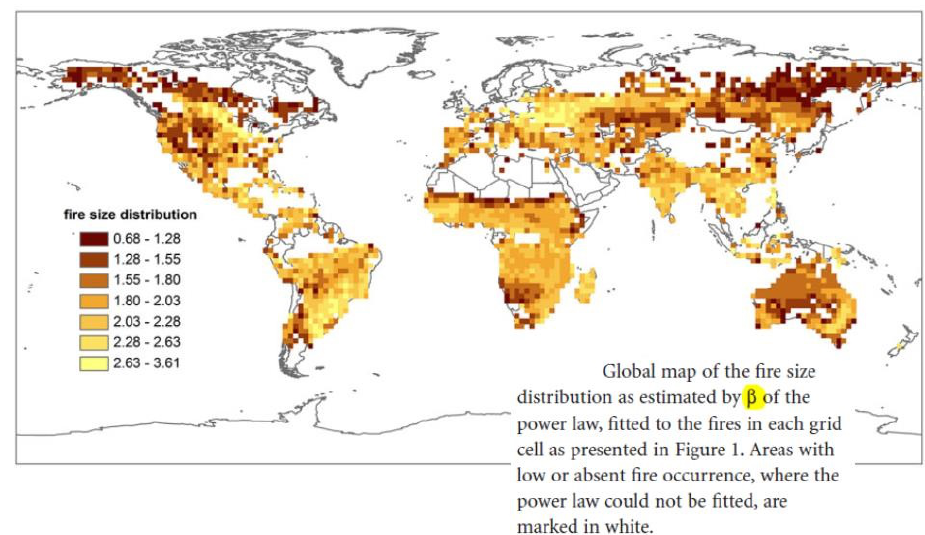
Figure 5. Comparison between spatial correlation map between the common time series (2001 – 2018) of FireCCI51-FireCCILT11 from Otón et al. [1] and global map of fire size distribution from Hantson et al. [4]. Higher values in the latter map correspond to fire size distributions where a large fraction of the total area burned is contributed by small fires, well below the detection ability of the FireCCILT11 product.